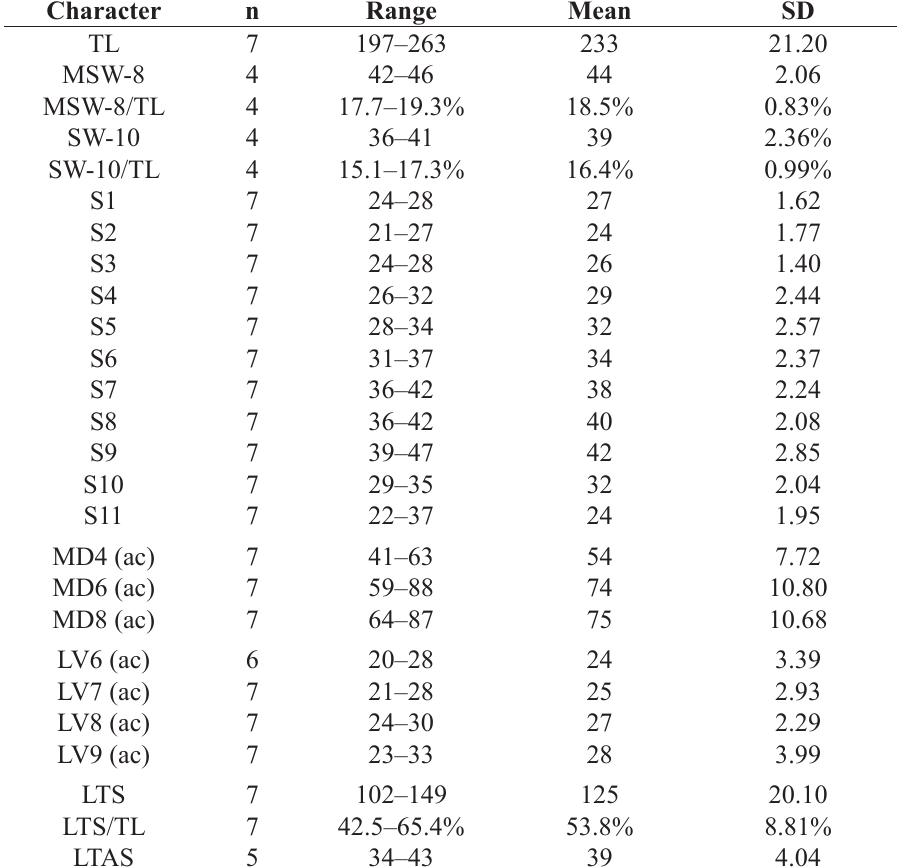
Table 6. Measurements from light microscopy of Echinoderes hamiltonorum sp. nov. (in µm), including number of measured specimens (n) and standard deviation (SD). Abbreviations: (ac) = acicular spine; LTAS = lateral terminal accessory spine; LTS = lateral terminal spine; LV = lateroventral; MD = middorsal; MSW-8 = maximum sternal width, measured on segment 8 in this species; S = segment lengths; SW-10 = standard width, always measured on segment 10; TL = trunk length. Fig. 9 (opposite page) . Scanning electron micrographs showing overviews and details of Echinoderes hamiltonorum sp. nov. A . Lateral overview. B . Ventral overview. C . Mouth cone. D . Introvert sector 8. E . Segments 1 to 3, dorsolateral view; note that laterodorsal sensory spots are missing in this particular specimen. F . Segments 1 to 3, ventral view. G . Detail showing lateral side of segment 8 without any indication of glandular cell outlets type 2. H . Segments 8 to 9, lateral view. I . Detail showing midlateral to lateroventral parts of segments 5 and 6. J . ♂, segments 10 to 11, dorsolateral view. K . ♂, segments 10 to 11, ventral view. L . ♀, segments 10 to 11, laterodorsal view. Abbreviations: ldgco2 = laterodorsal glandular cell outlet type 2; ldss = laterodorsal sensory spot; ldt = laterodorsal tube; ltas = lateral terminal accessory spine; lts = lateral terminal spine; lvs = lateroventral spine; lvt = lateroventral tube; mdss = middorsal sensory spot; mlss = midlateral sensory spot; oos = outer oral style; pdss = paradorsal sensory spot; pe = penile spines; psp = primary spinoscalid; sdgco2 = subdorsal glandular cell outlet type 2; sdss = subdorsal sensory spot; si = sieve plate; slgco2 = sublateral glandular cell outlet type 2; sp = spinoscalid followed by introvert ring number; te = tergal extensions; tr = trichoscalid; vlgco1 = ventrolateral glandular cell outlet type 1; vlss = ventrolateral sensory spot; vlt = ventrolateral tube; vmss = ventromedial sensory spot.